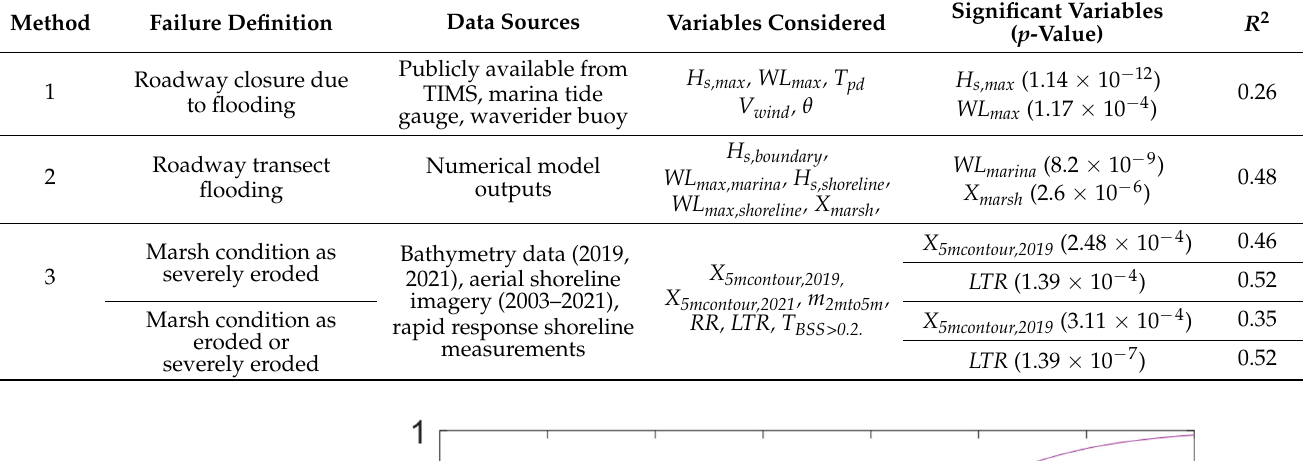
Table 3. Summary of fragility model derivation methods, definition of failure, data sources, varia ‐ bles considered, significant variables based on p < 0.01, and model R 2 values.